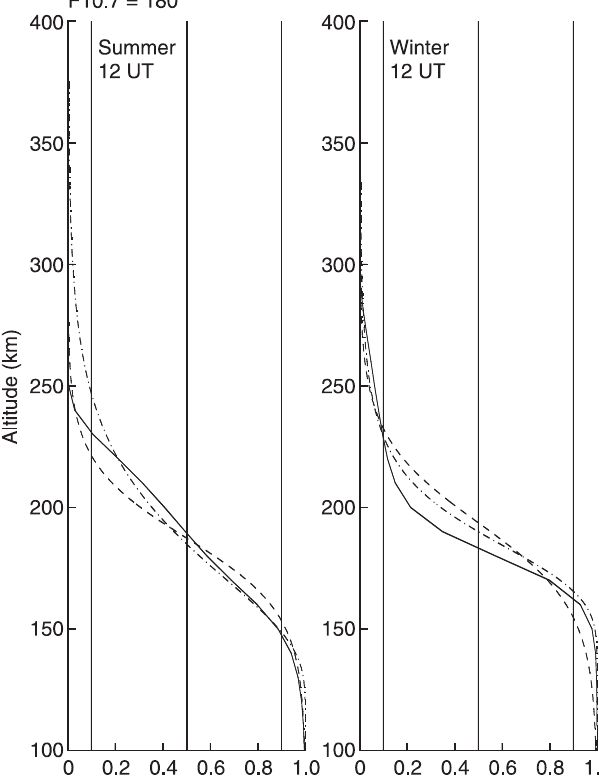
Fig. 6. The profiles modelled in this work ( dash-dotted line ) for high solar activity for winter and summer compared to the IRI model ( continuous line ) and to Lathuille` re and Pibaret’s (1992) model ( dashed line )